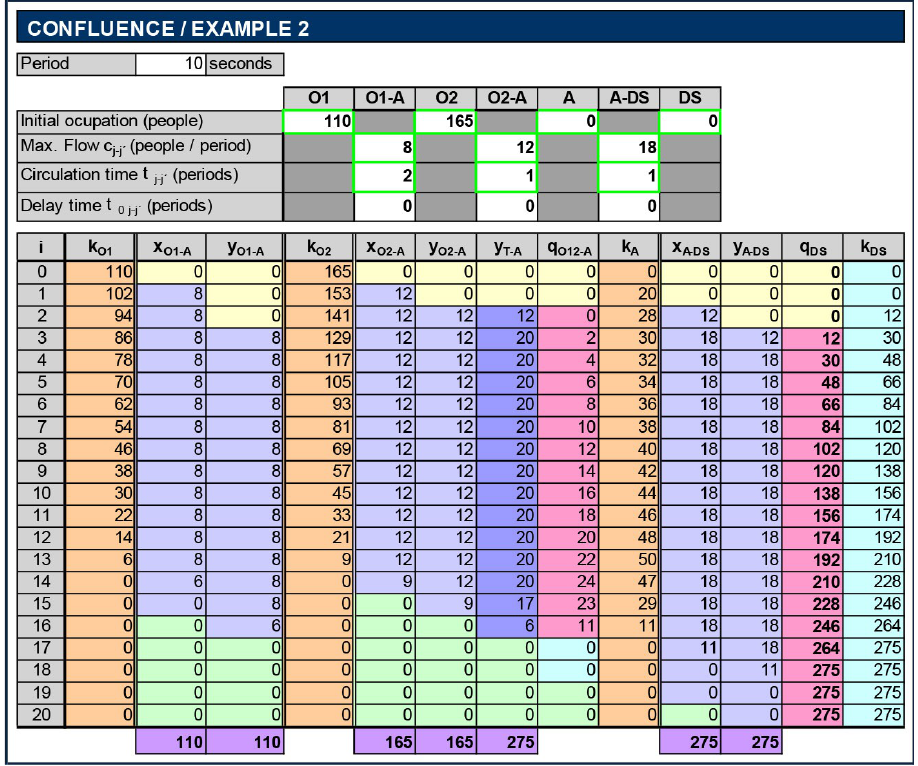
Figure 18. Example of a confluence result